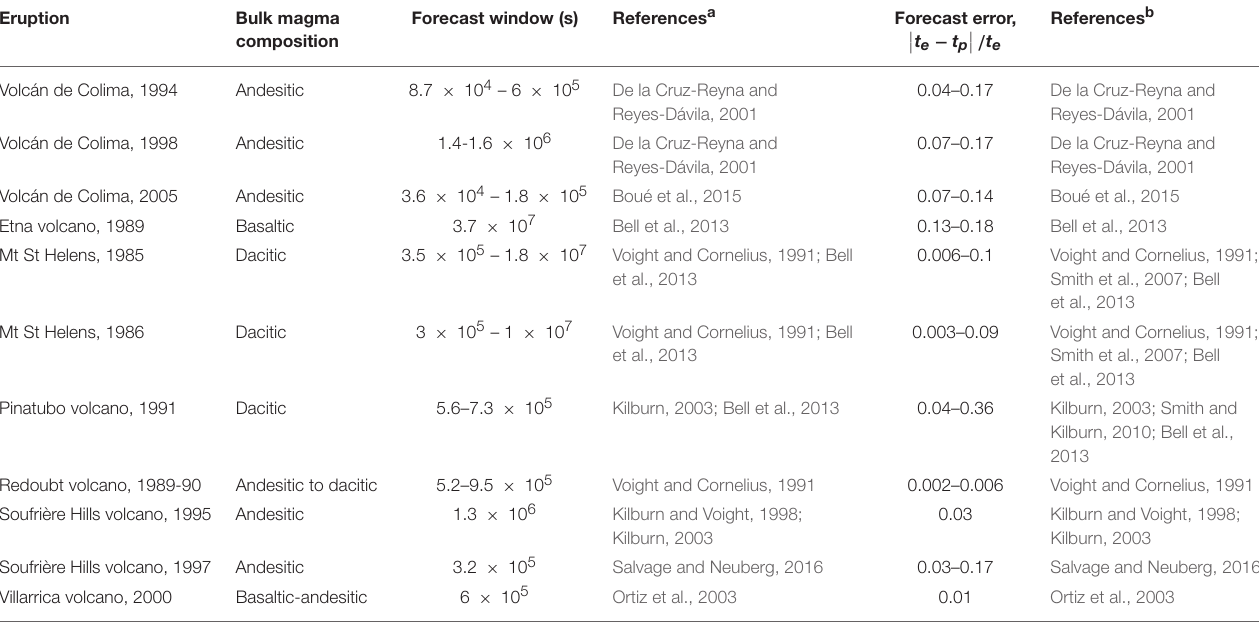
TABLE 1 | Accuracy of published retrospective eruption forecasts.